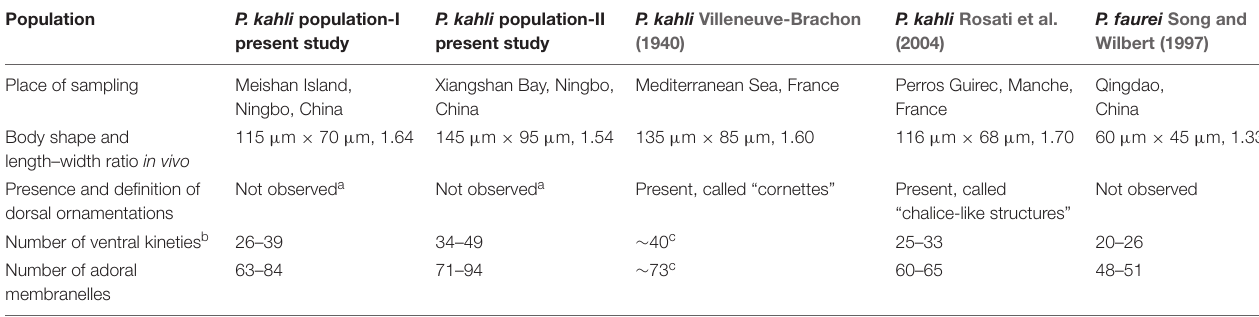
TABLE 2 | Comparison among different Peritromus